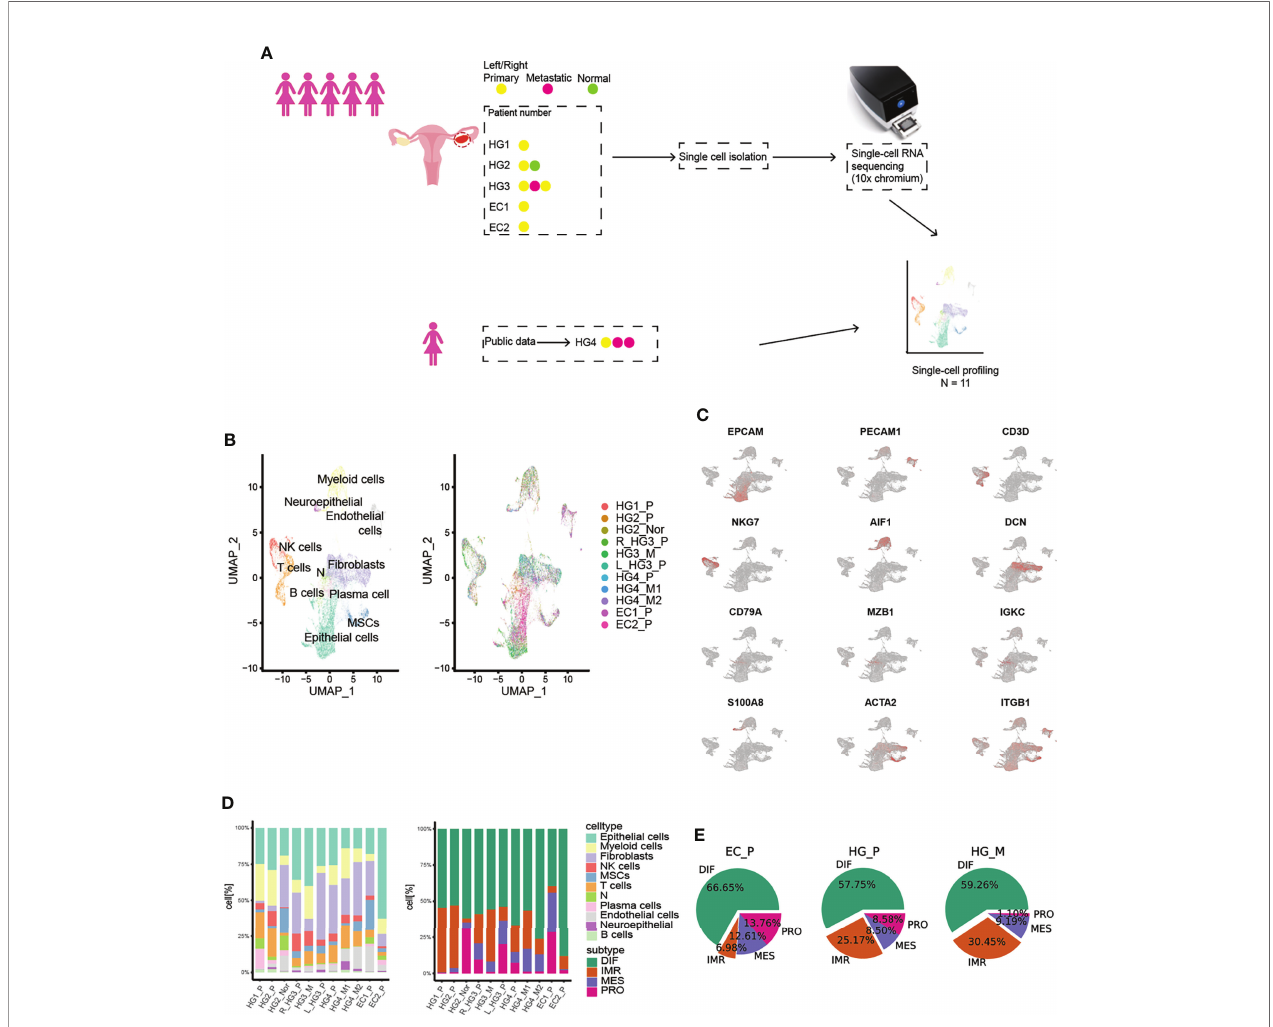
FIGURE 1 | Overview of TME in primary HGSOCs, metastatic HGSOCs, and ECs. (A) Work fl ow of the samples collected and the data analysis strategy. (B) Cell populations identi fi ed. The UMAP projection of 55802 single cells from HG_P (n=5), HG_M (N=3), EC_P (n=2), HG_Nor (n=1) samples shows the 10 main clusters with annotation. Each dot corresponds to a single cell, colored according to cell type. (C) Canonical cell markers are used to identify the clusters. (D) Barplots of the cell type and cancer subtypes for all 11 tumors. (E) The cancer subtypes proportion for each pathological